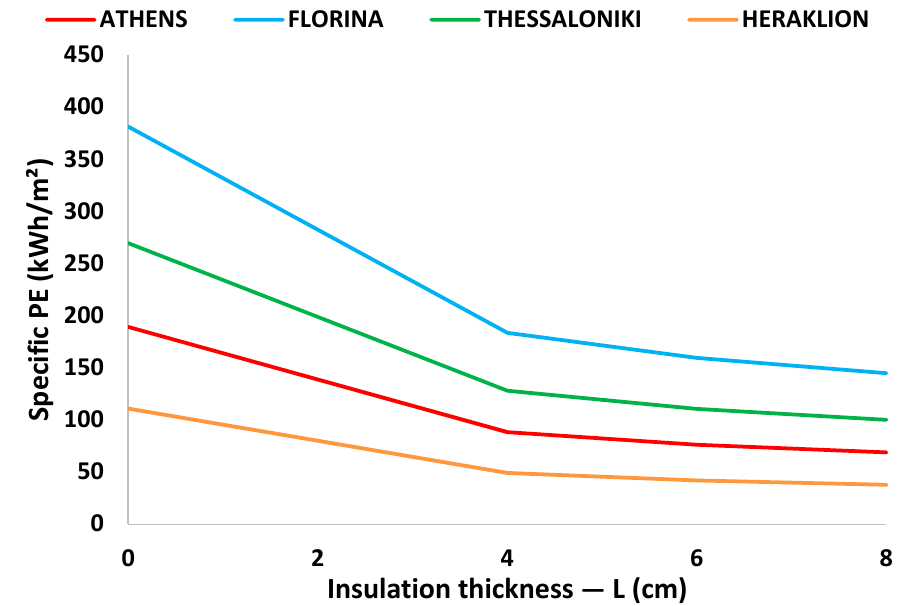
Figure 5. Specific primary energy consumption for the examined cases.